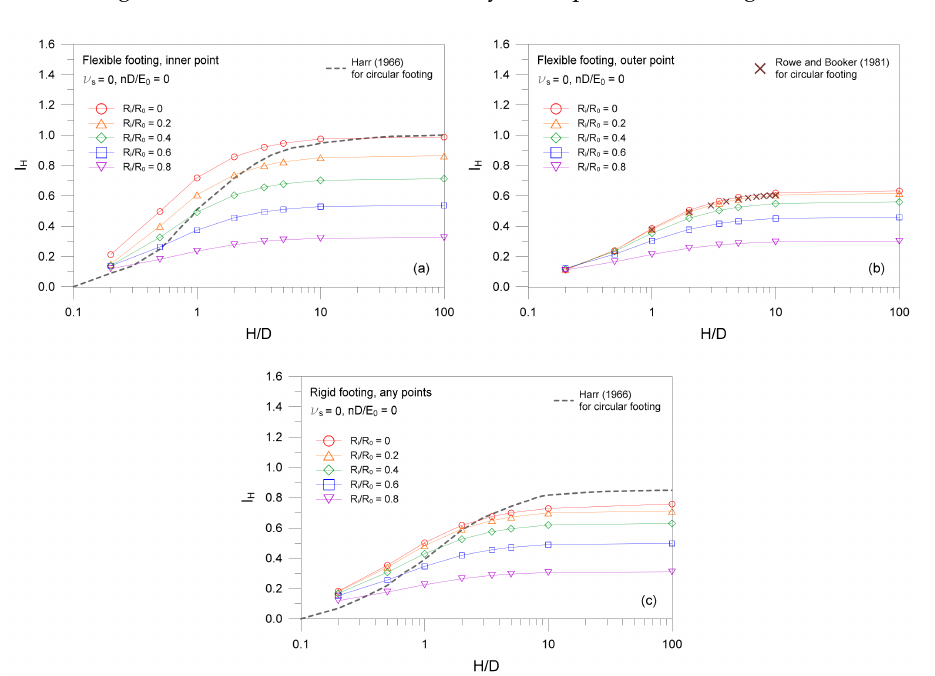
Figure 6. Variation of I H with H / D for ring footings on a homogeneous finite layer overlying rigid base: ( a ) flexible footing of inner point; ( b ) flexible footing of outer point; ( c ) rigid